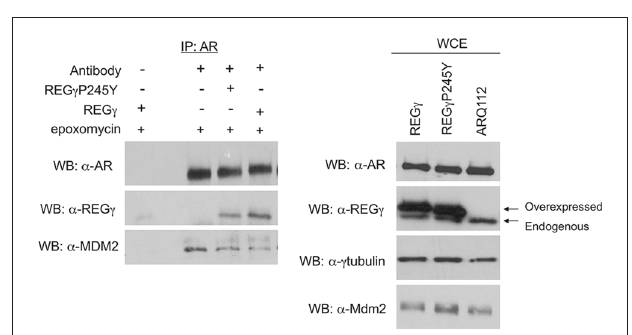
FIGURE 7 | Overexpression of REG γ decreases ARQ112 interaction with MDM2. PC12 ARQ112 cells stably overexpressing REG γ or REG γ P245Y were induced with Dox for 48 h and treated with DHT and epoxomycin for the last 15 h. Protein lysates were harvested at 48 h and then AR was co-immunoprecipitated with AR(H280) antibody (left). Protein complexes were evaluated via Western blot analysis using AR(441), REG γ and MDM2 antibodies. (Right) Western blots of whole cell lysates (WCE) used for IP were probed with antibodies detecting REG γ , AR (AR(318)), MDM2 and γ